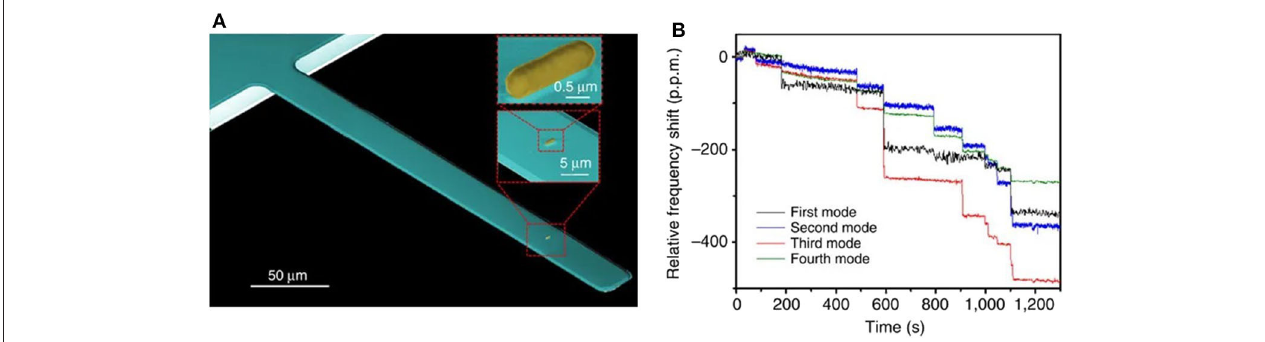
FIGURE 2 | Bacteria detection with dynamic mode nanomechanical sensors. (A) SEM image of a cantilever with an E. coli cell. (B) Real-time record of the fractional shifts of the resonance frequencies of the first four vibration modes of the microcantilever during bacteria adsorption. The time-correlated frequency jumps correspond to adsorption events of single bacterial cells. Reprinted from Malvar et al.